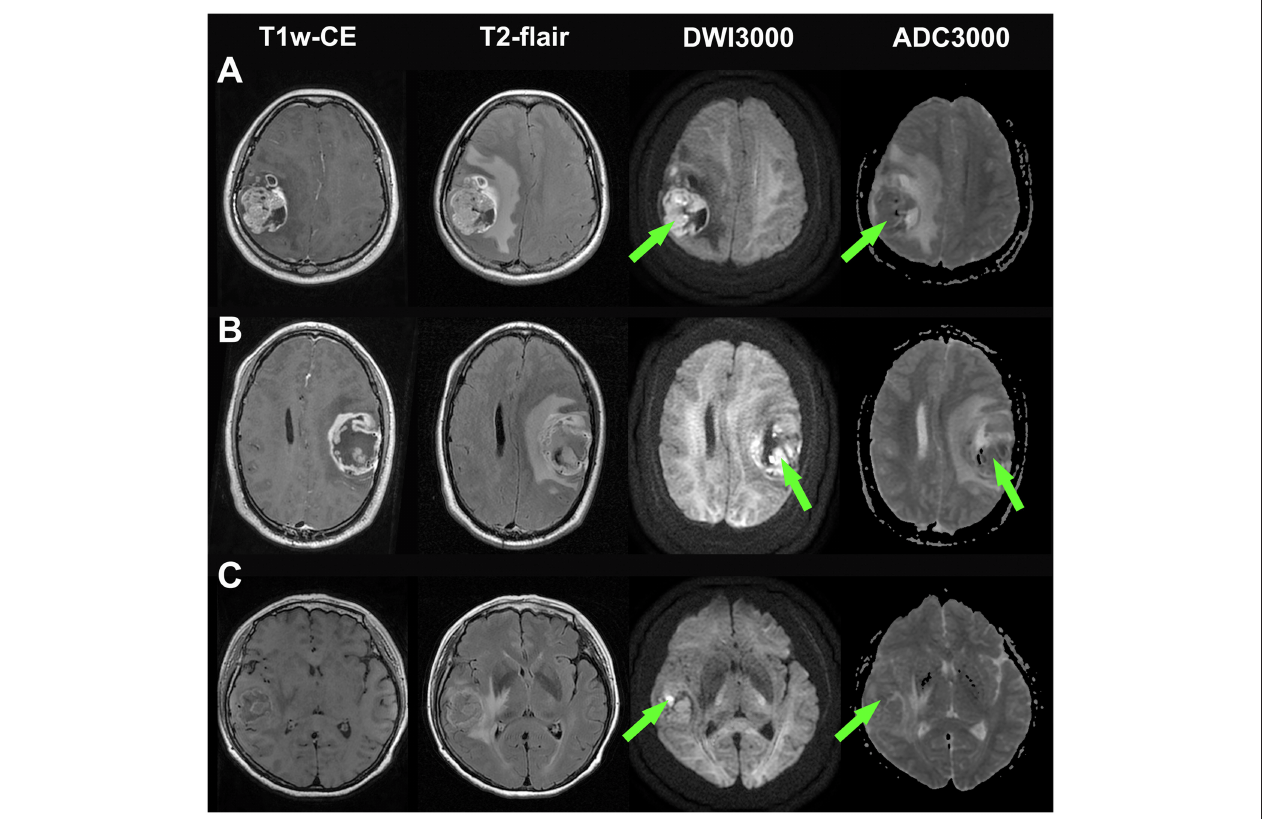
FIGURE 2 | Illustrations of three glioblastomas without bright edge sign. (A) a glioblastoma patient who had survived for 30 months (still alive at last time follow-up), (B) a glioblastoma patient who had a survival time of 33 months, and (C) a glioblastoma patient who had a survival time of 24 months. T1-weighted contrast-enhanced images, T2-flair contrast-enhanced images, DWI maps with b = 3,000 s/mm 2 and ADC maps with b = 3,000 s/mm 2 are shown in the first to forth rows, respectively. Note that extremely high signal regions exist within tumor regions on DWI maps (Green